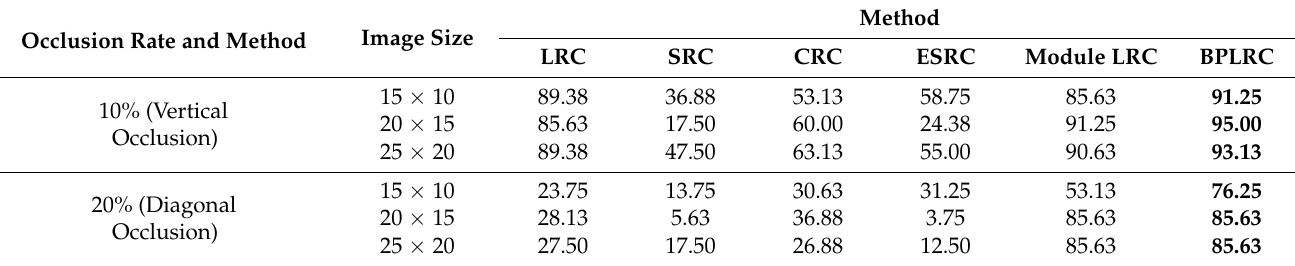
Table 8. Accuracy (%) of different methods when identifying 10% vertically and 20% diagonally occluded face images from the ORL database. Table 7. Accuracy (%) of different methods when identifying 10%-, 20%-, 30%-, and 40%-occluded face images from the ORL database.